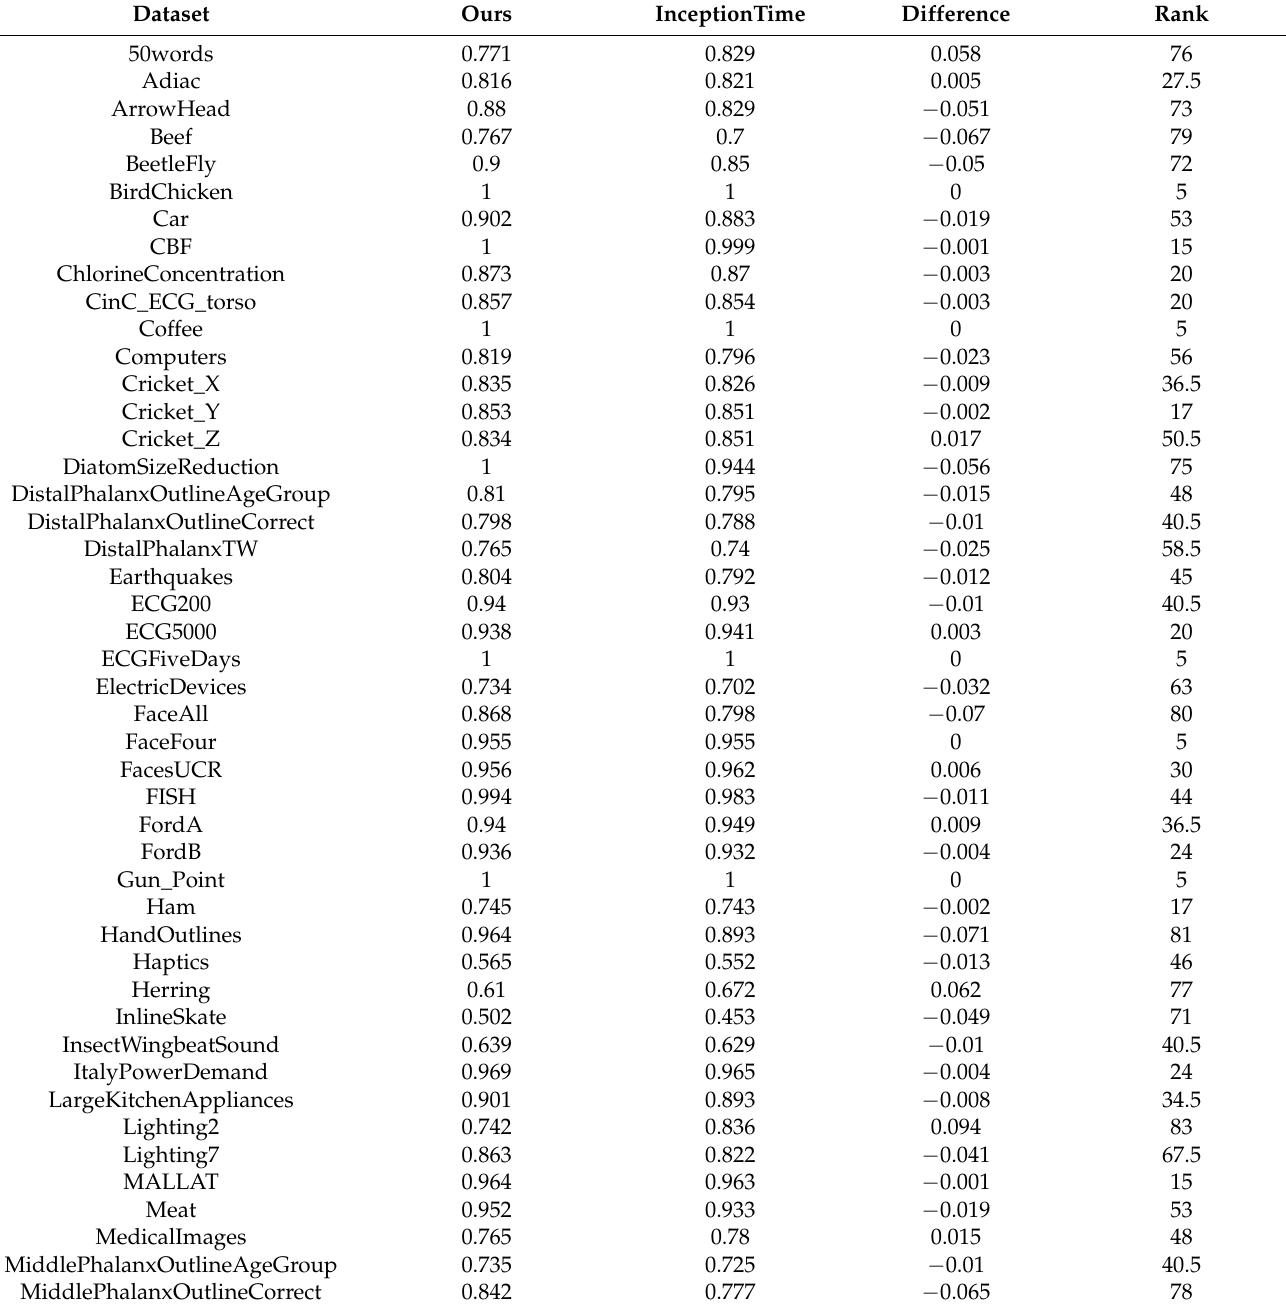
Table 4. Differences and ranks for two